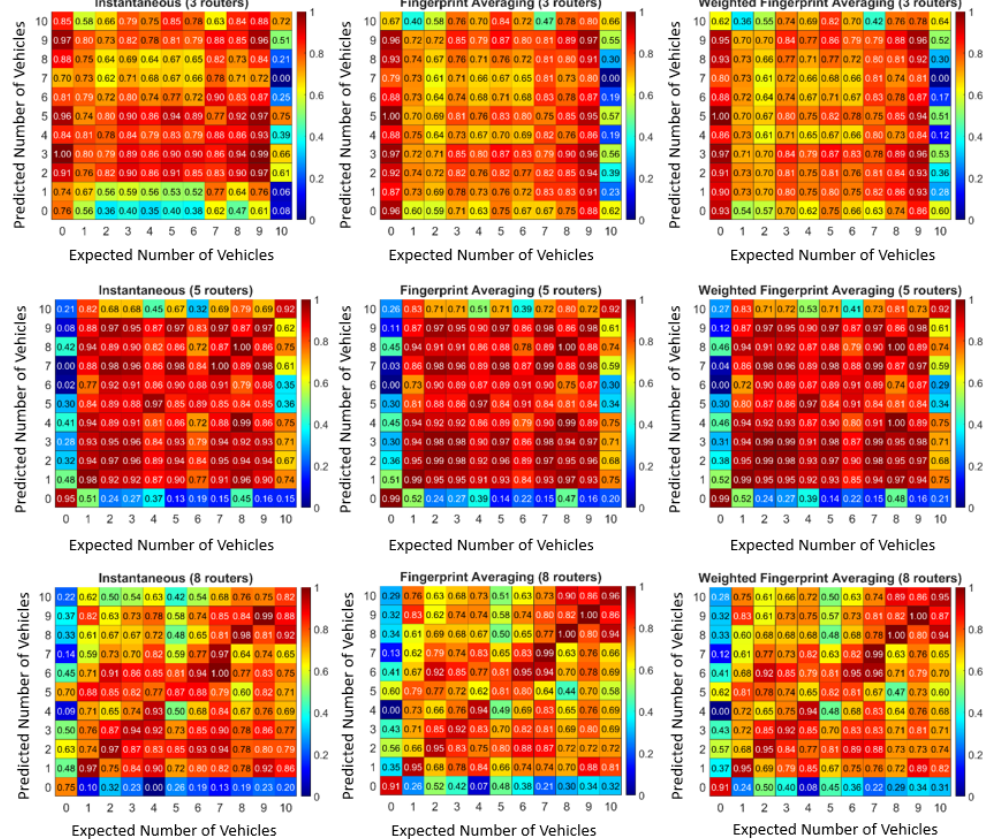
Figure 5. Comparing the online and offline correlation values employing instantaneous ( left column), averaging method ( center column), and weighted averaging ( right